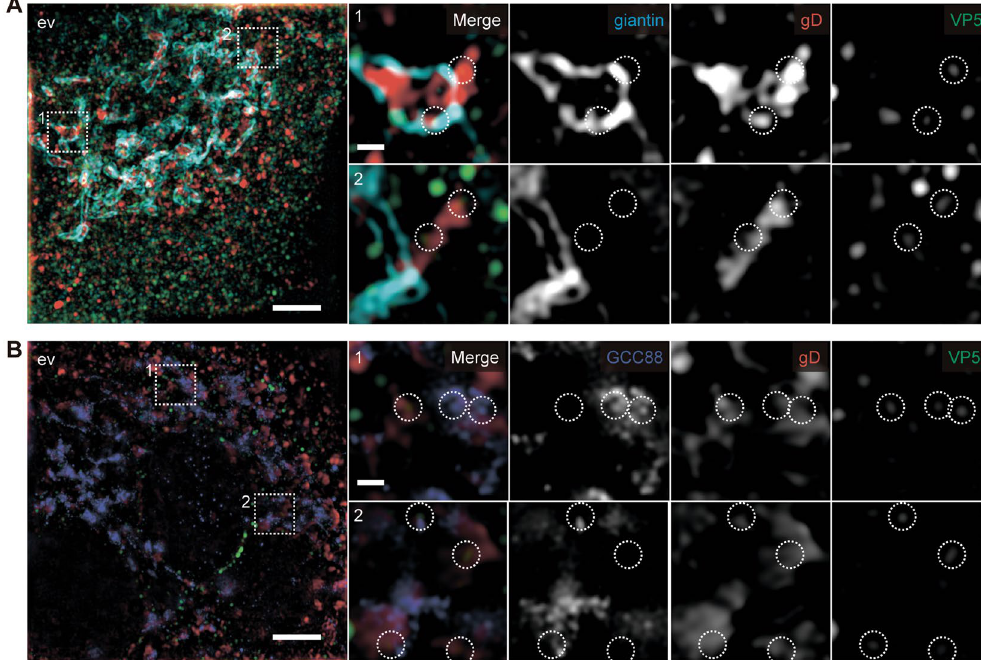
Figure 2. The trans -cisternae of the Golgi apparatus are a potential membrane compartment for secondary envelopment. ( A and B ) Representative super-resolution images of HSV-1-infected A549 cells (moi of 5/12 hpi) transfected with control (ev) lentivirus vector. Cells were simultaneously stained with anti-gD antibody (red) and anti-VP5 antibody (green) in combination with anti-giantin antibody ( A , cyan) or anti-GCC88 antibody ( B , blue). The farthest left panels show z-stack images reconstructed by maximum intensity projection (bars, 5 µ m). The other panels show magnifications of the two areas boxed with dashed lines (1,2) in the left panels (bars, 1 µ m). The circles indicate capsids associated with or included in gD-positive membrane